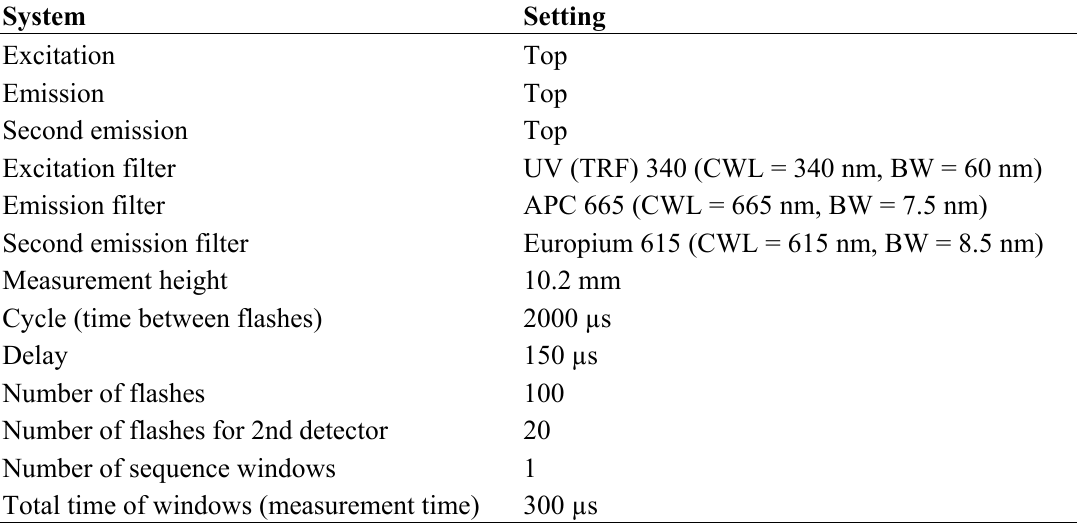
Table 2. EnVision ® Xcite Multilabel Plate Reader setup for HTRF ® measurement. CWL: center wavelength; BW: